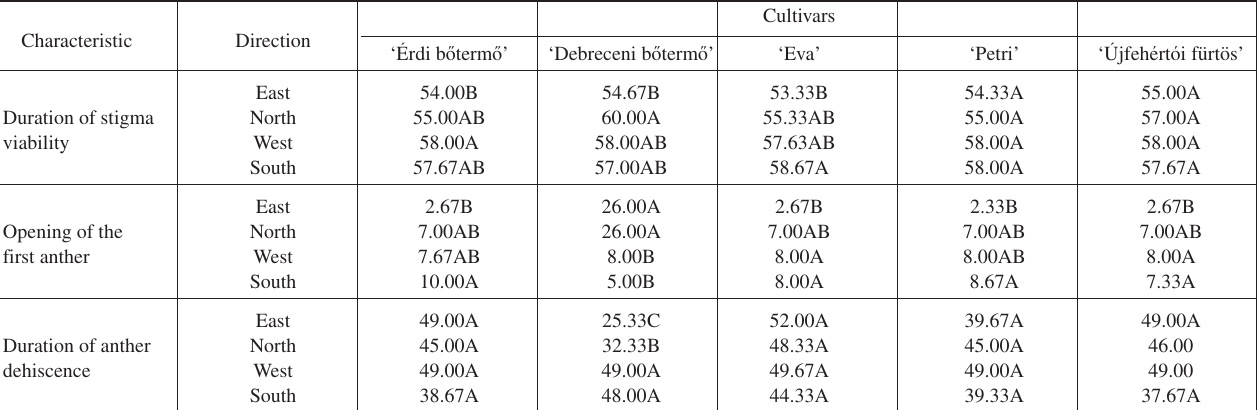
Table 2. Characteristic features of flower microphenology in four directions of the tree